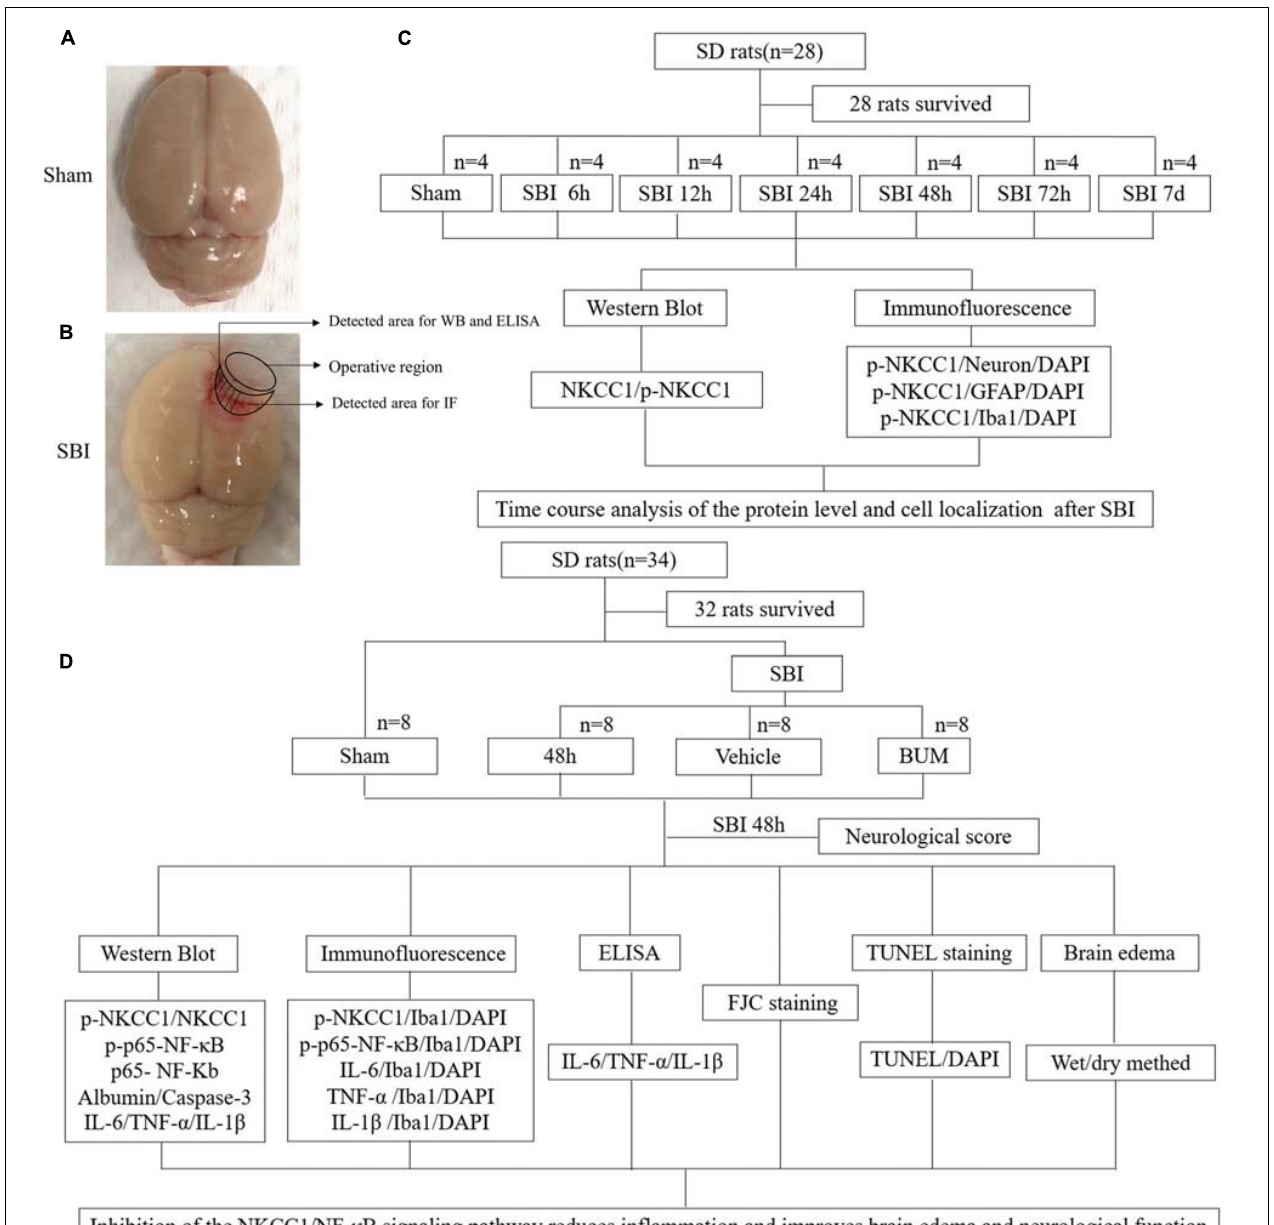
FIGURE 1 | SBI model and experimental design. Brain tissues obtained from the perioperative area of the SBI group and from the same site in the sham group were assessed, some tissues were used for WB, IF staining, and ELISA (A,B) . NKCC1 and p-NKCC1 expression levels and locations of p-NKCC1 in nerve cells post SBI and determination of the optimal time point for the subsequent experiment (C) . Assessment of the effects of the NKCC1/NF- κ B pathway post SBI and elucidation of potential mechanisms (D)